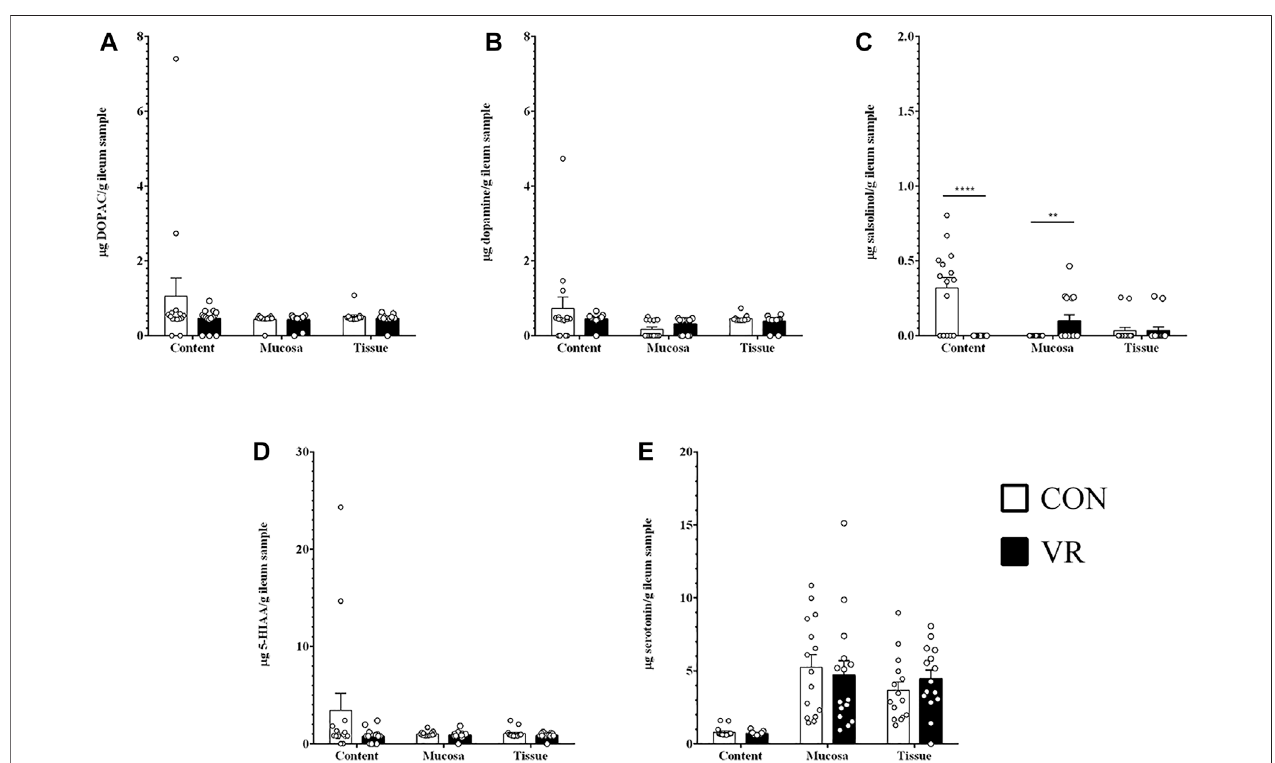
FIGURE 3 | Neurochemical metabolite levels in chicken ileum ( n = 15/group) measured by U-HPLC. (A) , DOPAC. (B) , dopamine. (C) , salsolinol. (D) , 5-HIAA. (E) , serotonin. ** p < 0.01; **** p < 0.0001.